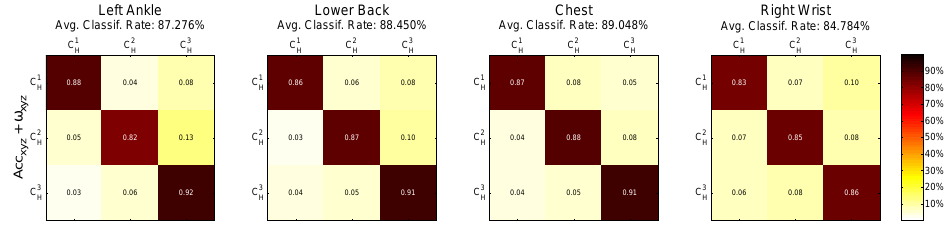
Figure 4. Confusion matrices of body height classification computed with 10-fold cross-validation. Each column presents the sensor position (left to right): left ankle, lower back, chest and right wrist. 6D accelerations and angular velocities (50 features) were used for classification. C 1 C 2 : 170 cm < height < 180 cm, C 3 : height ≥ 180 cm. H H